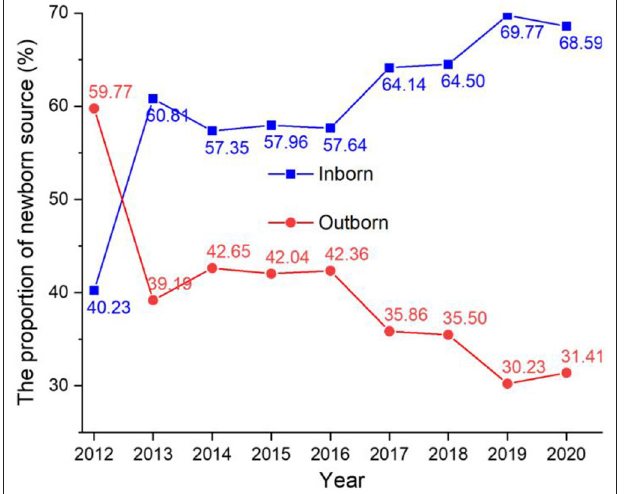
FIGURE 5 | The proportion of newborns by source (inborn/outborn) from 2012 to 2020.